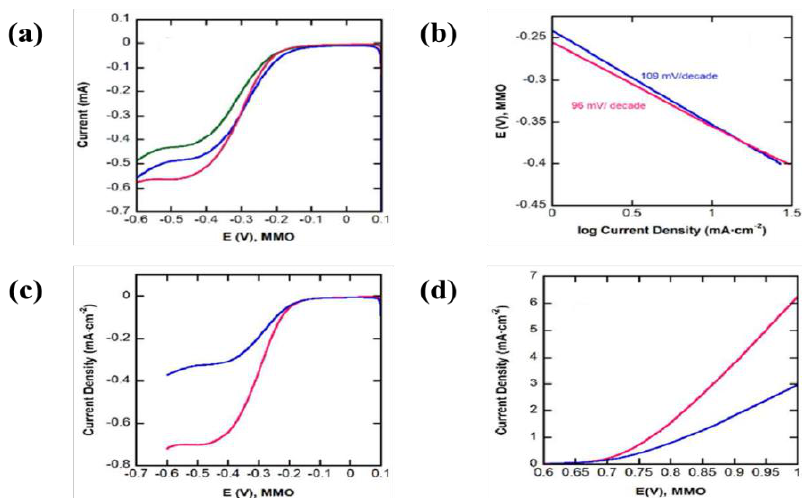
Figure 30. ( a ) ORR polarization curves for the Co 3 O 4 nanoparticle thin film electrode deposited by EPD (pink) and dropcast (blue and green); ( b ) Tafel plots of the dropcast and EPD thin film electrodes derived by the mass-transport correction of corresponding RDE data (Rotation speed: 1600 RPM); ( c ) ORR polarization curves for Co 3 O 4 nanoparticle thin film electrode deposited by EPD (pink) and dropcast (blue) after adjusting for the surface area; ( d ) OER polarization curves for the Co 3 O 4 nanoparticle thin film electrode deposited by EPD (pink) and dropcast (blue) after adjusting for the surface area.